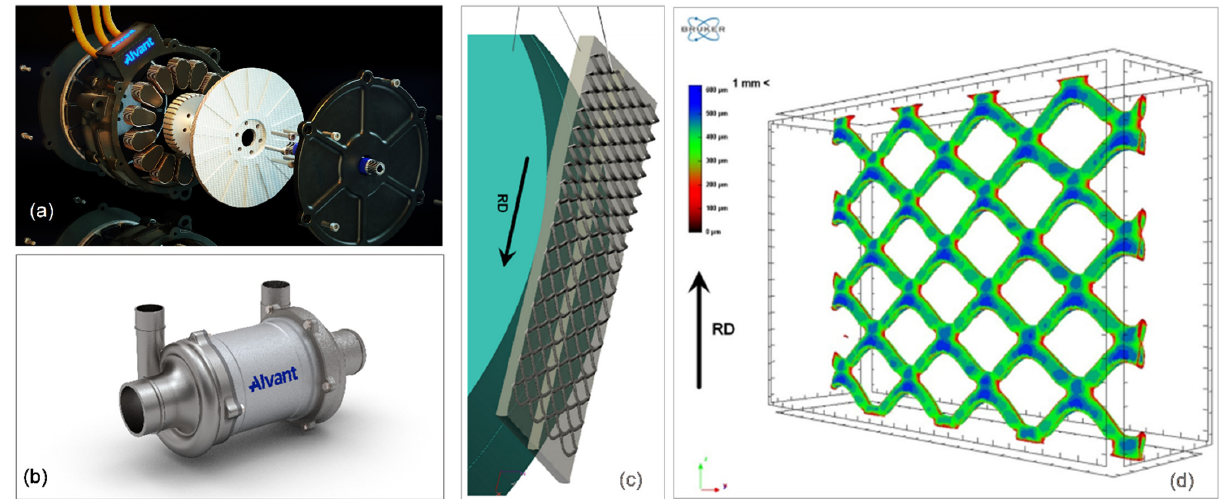
Figure 15. Aluminum matrix composite use in automotive parts: ( a , b ) MMC rotor of an axial flux electric motor and a hydrogen fuel cell compressor developed by Alvant, UK [86] and ( c , d ) composite manufactured by a reinforcement of the aluminum matrix through a steel mesh [87].